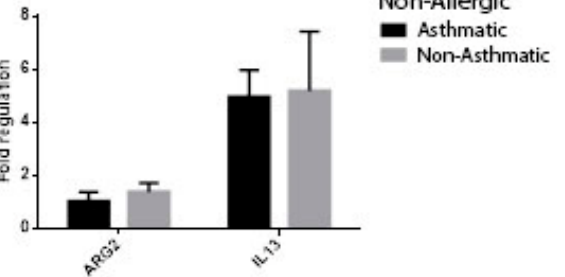
Figure 8. ARG2 and IL-13 expression in patients with non-allergic CRS: asthmatic vs. non-asthmatic, p = 0.02.